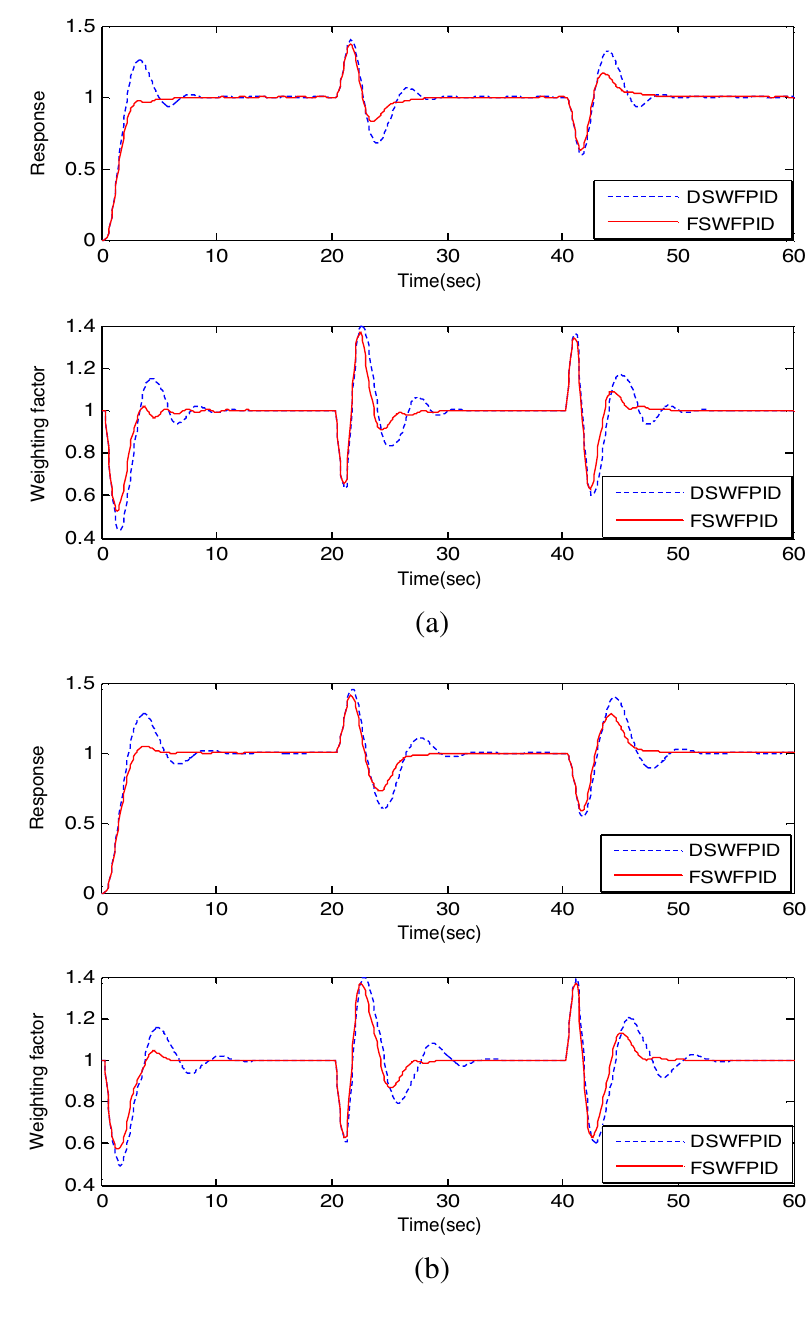
Fig. 9 Variation of weight- ing factor corresponding to closed-loop responses provided by DSWFPID and FSWFPID for Model I with a 49 rules and b 25